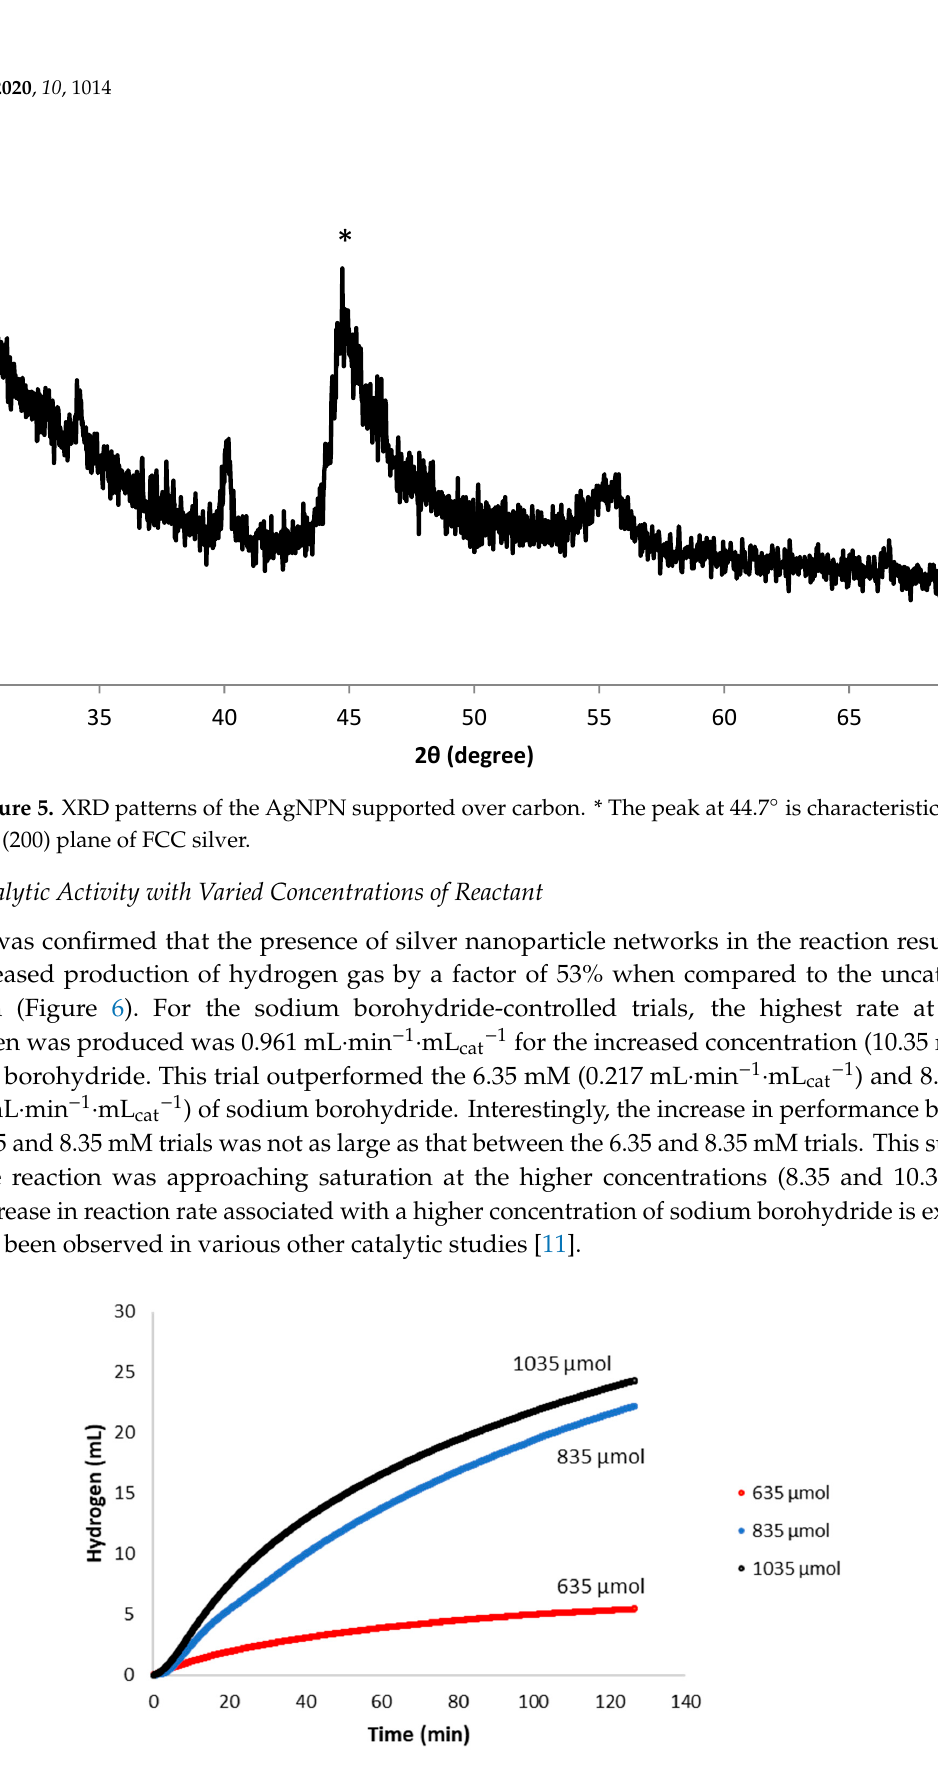
Figure6. ComparisonofthevolumeofhydrogengasgeneratedversustimebytheAgNPN.Thereactions were run at 835 µ moles (8.35 mM), 1035 µ moles (10.35 mM), and 635 µ moles (6.35 mM) of NaBH 4